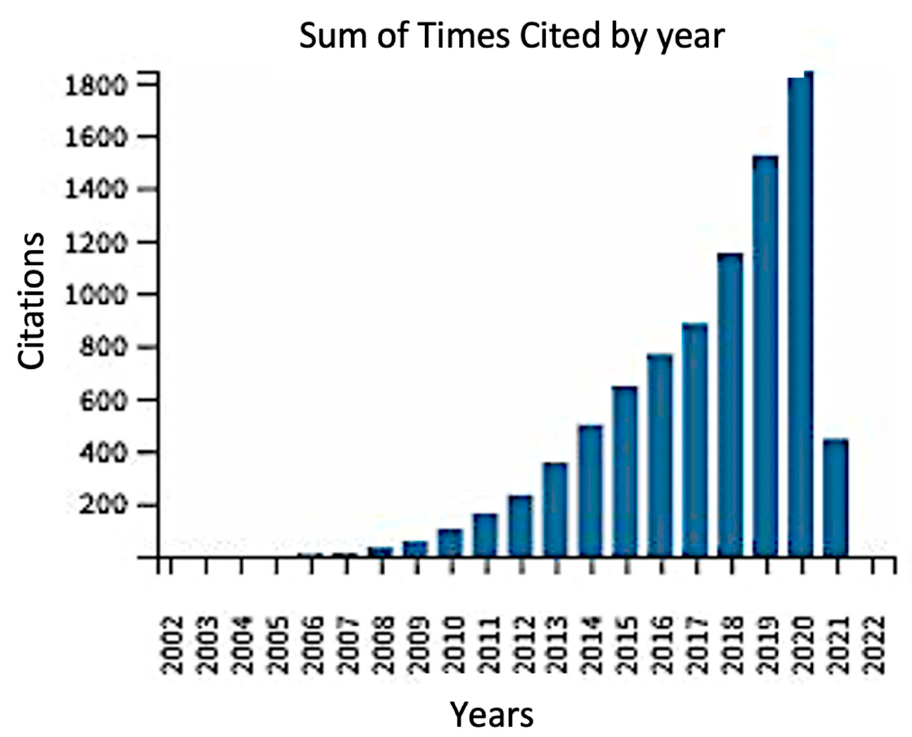
Figure 11. Citation report for 508 results from Web of Science Core Collection.